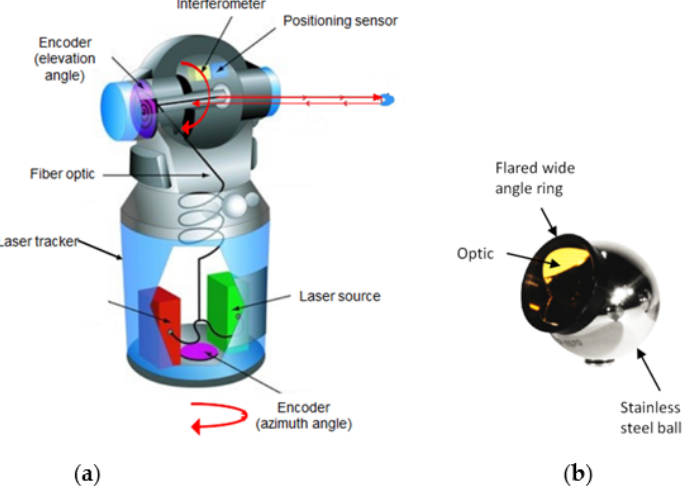
Figure 1. Laser tracker: ( a ) Laser tracker components; ( b ) SMR (Spherically Mounted